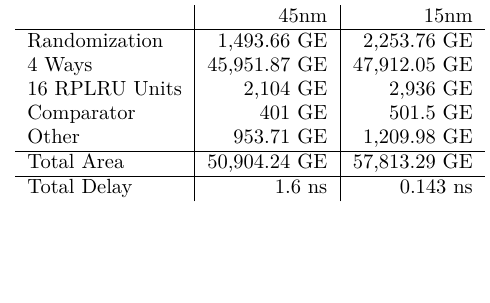
Table 4: Hardware overhead and time delay added by TLBcoat for different manufacturing